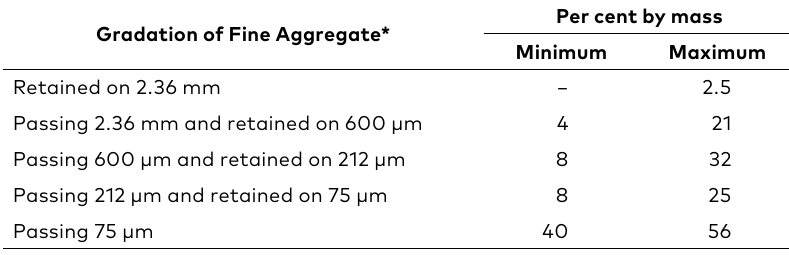
Table 2. Specified gradation of limestone fine aggregate Per cent by mass Gradation of Fine Aggregate*